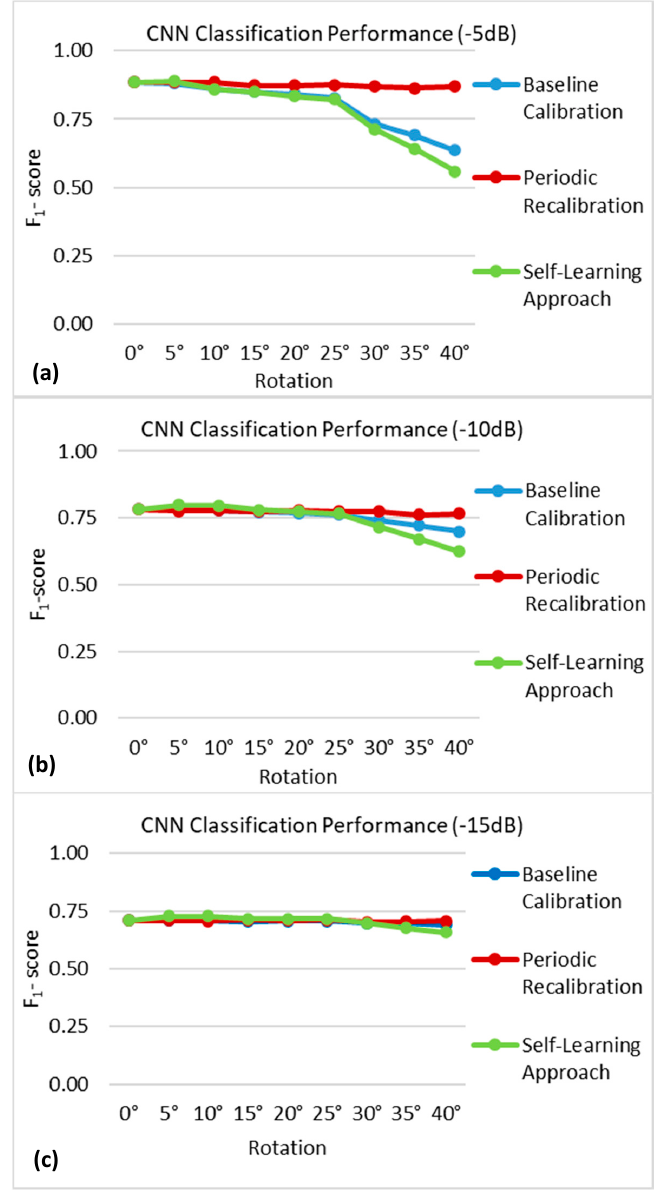
Figure 9. F 1 -scores obtained in the rotation of the cuff electrode simulation using the baseline calibration (blue), periodic recalibration (red), and self-learning (green) update approaches at different time points (represented here as additional models) using measurements with ( a ) − 5 dB, ( b ) − 10 dB, and ( c ) − 15 dB of noise added. The standard deviations at each time point were all below 0.008 and are therefore not displayed here for ease of